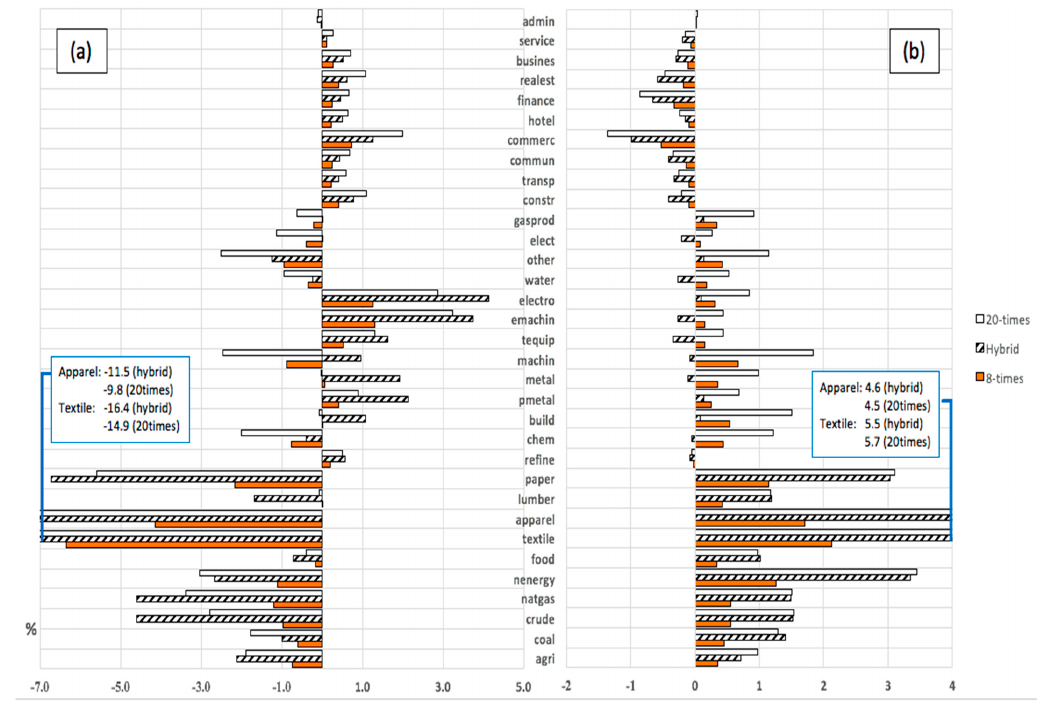
Figure 3. Impact of water pollution taxes on ( a ) industry output, and ( b ) industry prices in 2030 (percent change from base case). All abbreviations are shown in Table A1.